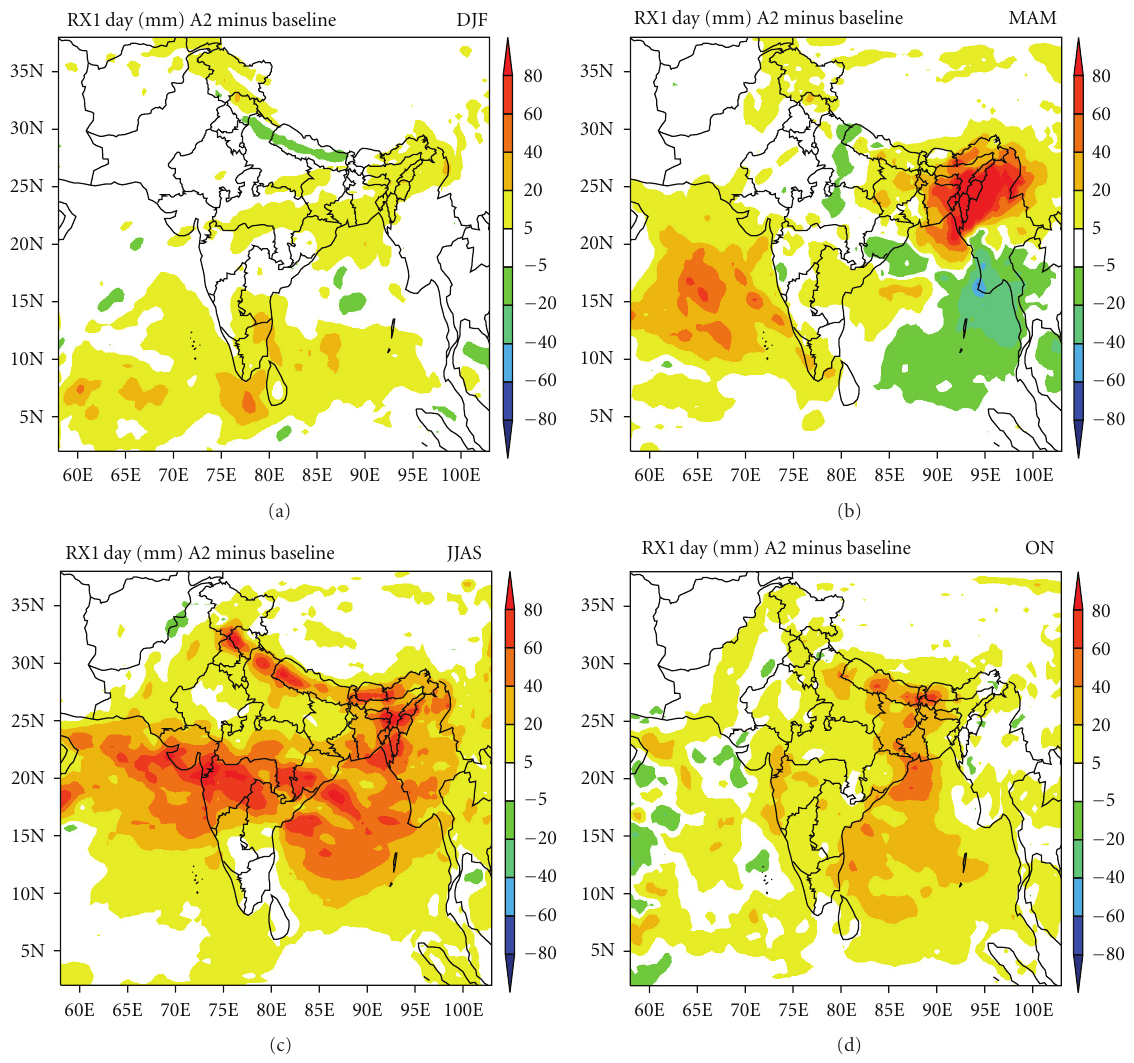
Figure 2: Spatial patterns of changes in seasonal one-day maximum precipitation in mm, RX1day { A2 (2071–2100) minus